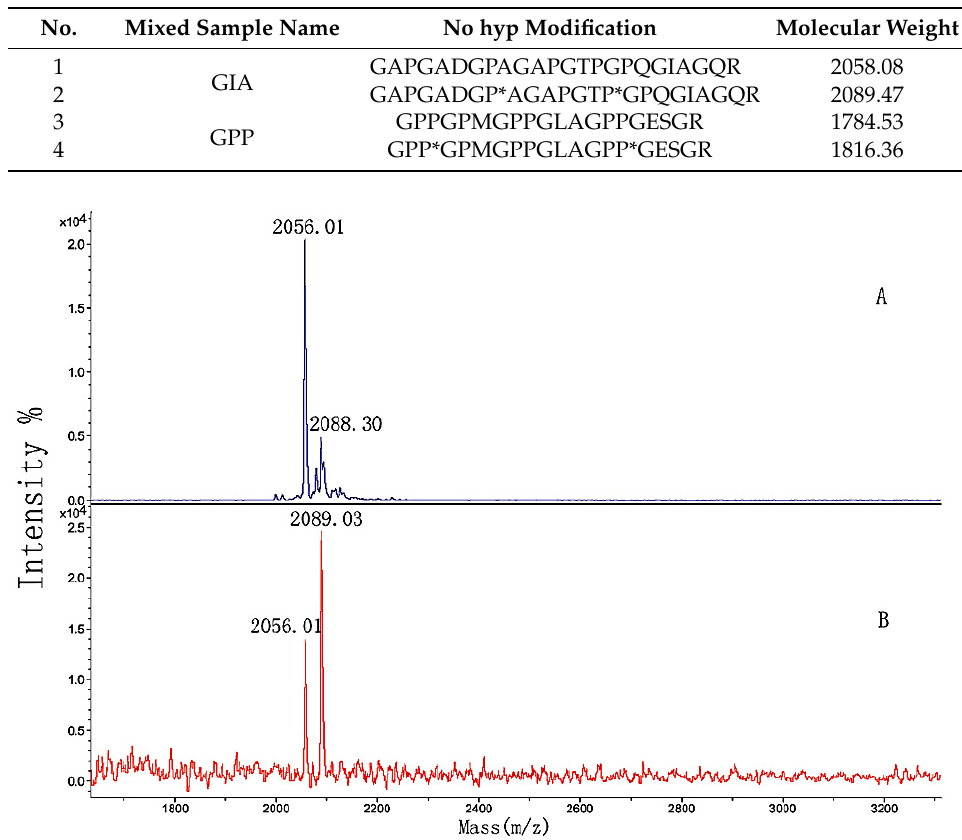
Table 2. Sequence and molecular weight of the four synthesized peptides.